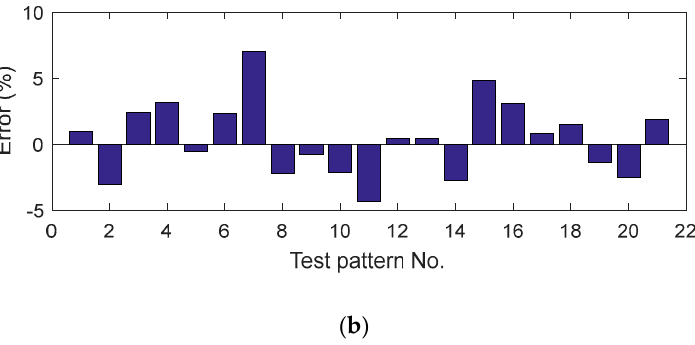
Figure 14. Estimated yield displacement results: ( a ) comparison of yield displacement; ( b ) error.